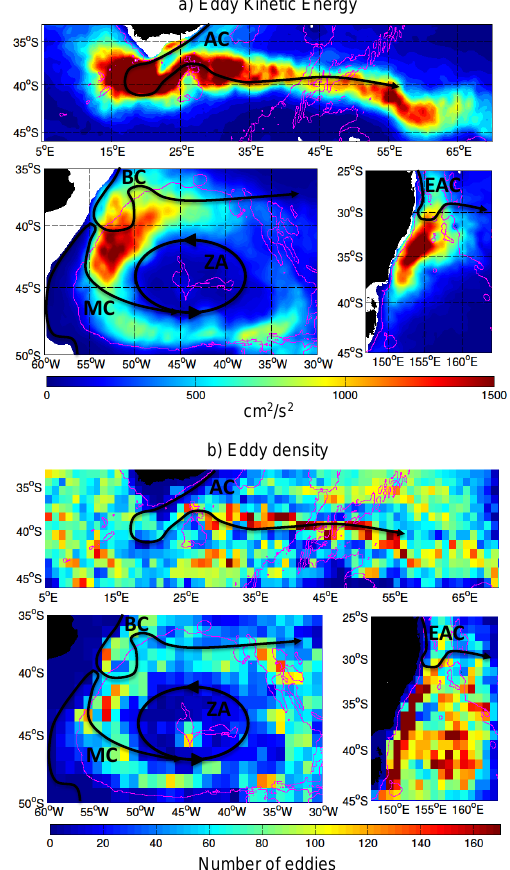
Figure 2. (a) Mean eddy kinetic Energy between January 1993 and December 2011 and (b) total number of eddies occurring in each 1 ◦ × 1 ◦ cell between October 1992 and April 2012 in the AC, BC and EAC